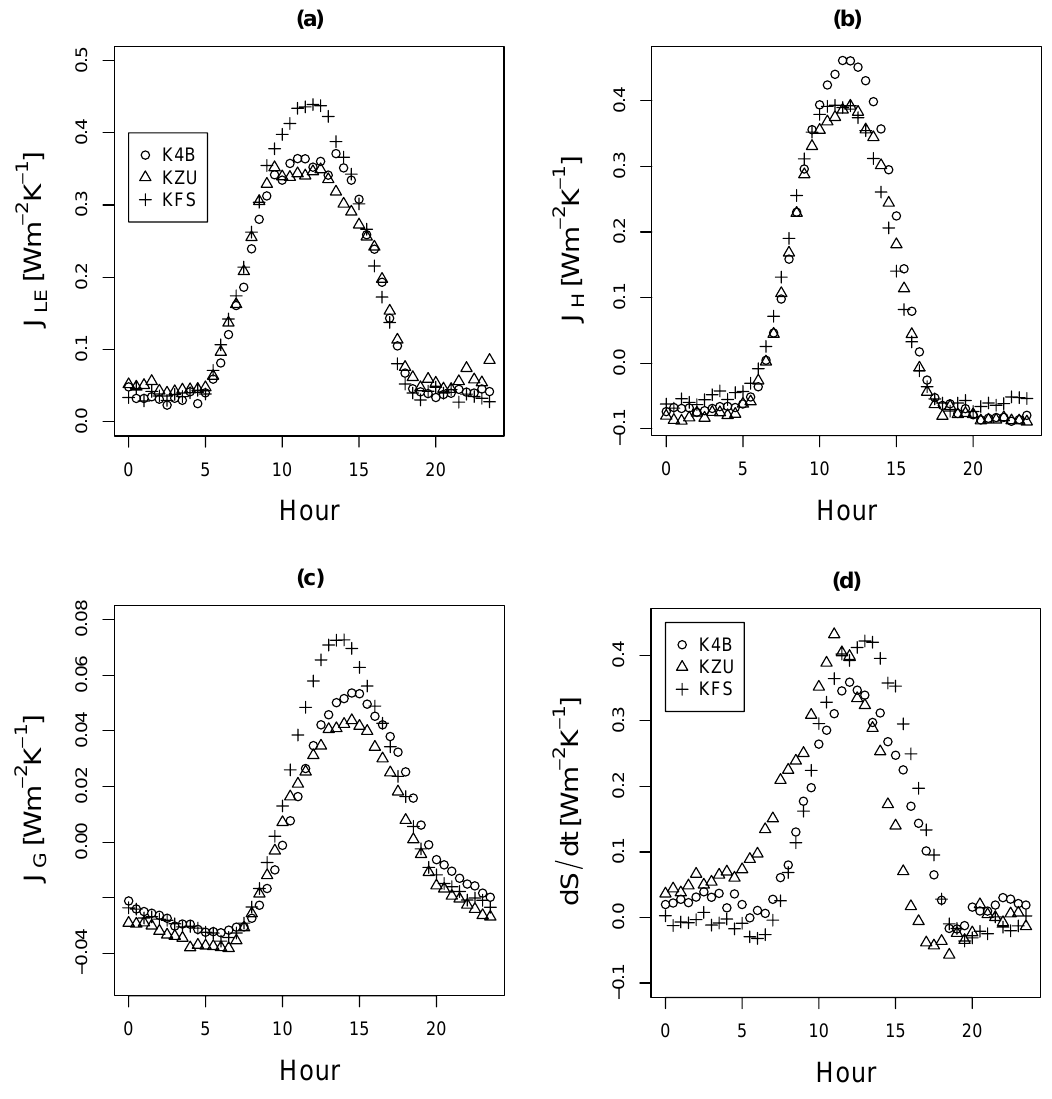
Fig. 11. Mean diurnal entropy terms associated with (a) transfer due to latent heat flux (b) transfer due to sensible heat flux (c) transfer due to soil heat flux and (d) the overall entropy budget computed from the eddy covariance